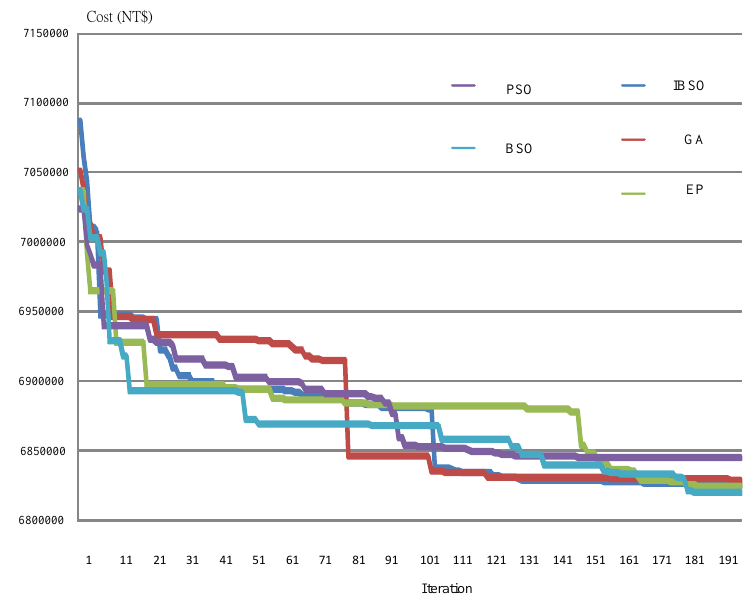
Figure 14. Convergence characteristics of the EP, GA, PSO, BSO, and IBSO algorithms in the stand-alone scenario.